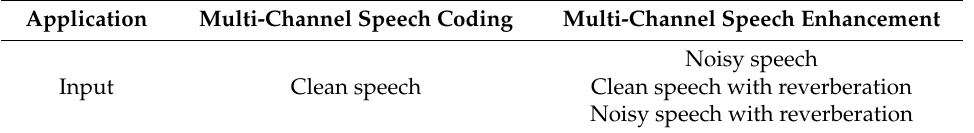
Table 4. Applications of the MASS.